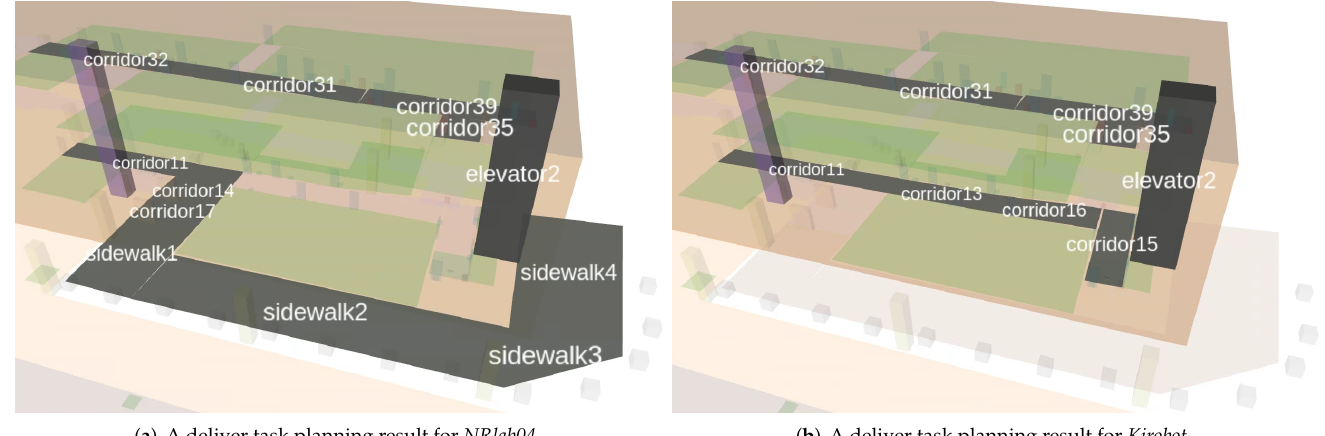
Figure 5. Different task planning results according to different classes of Robot